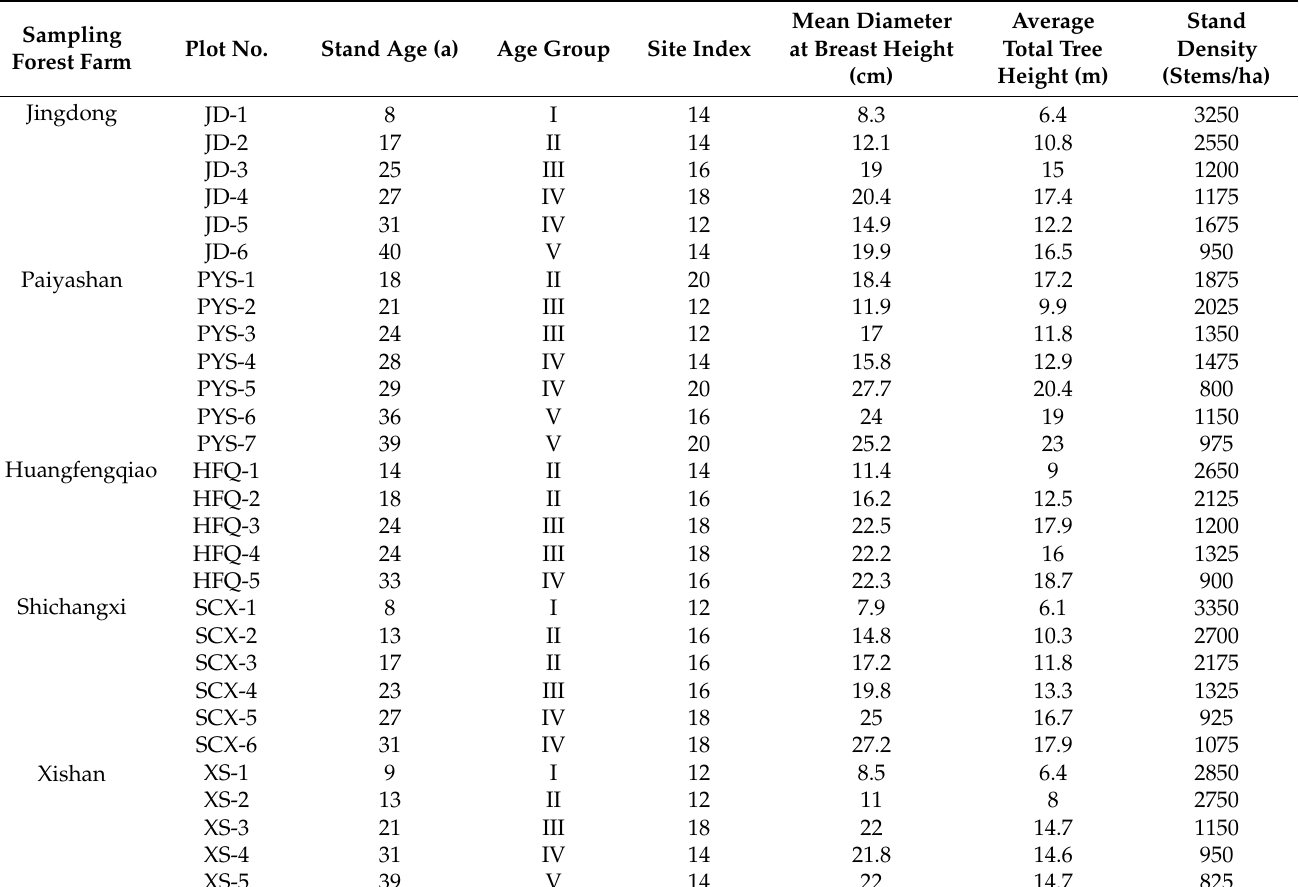
Table 1. Stand characteristics from temporary plots established in 5 Chinese fir plantations in Hunan